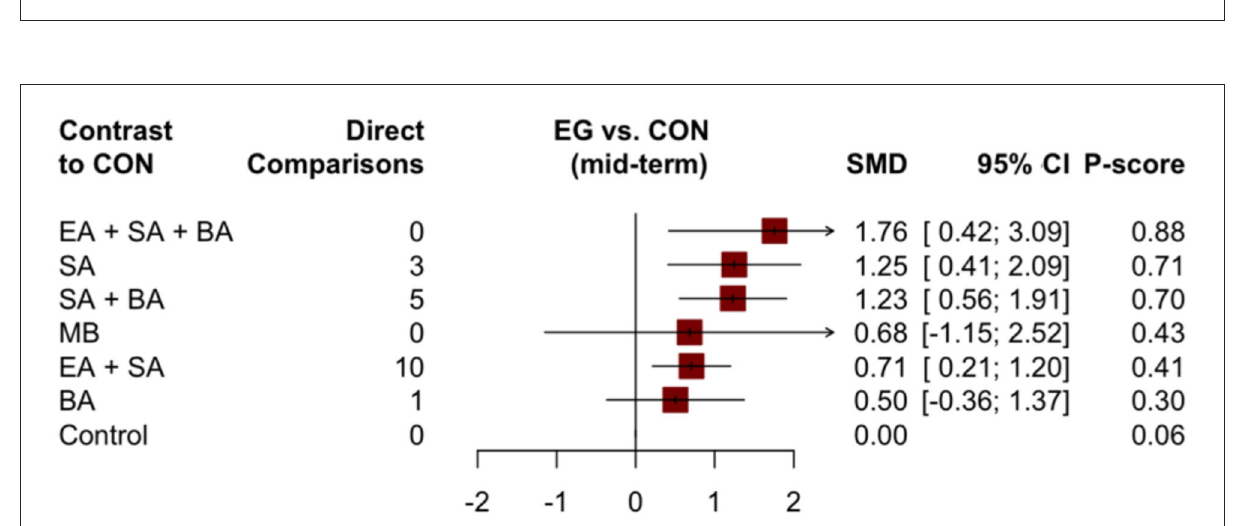
FIGURE6 Forest plot compared with the control group of cognitive function